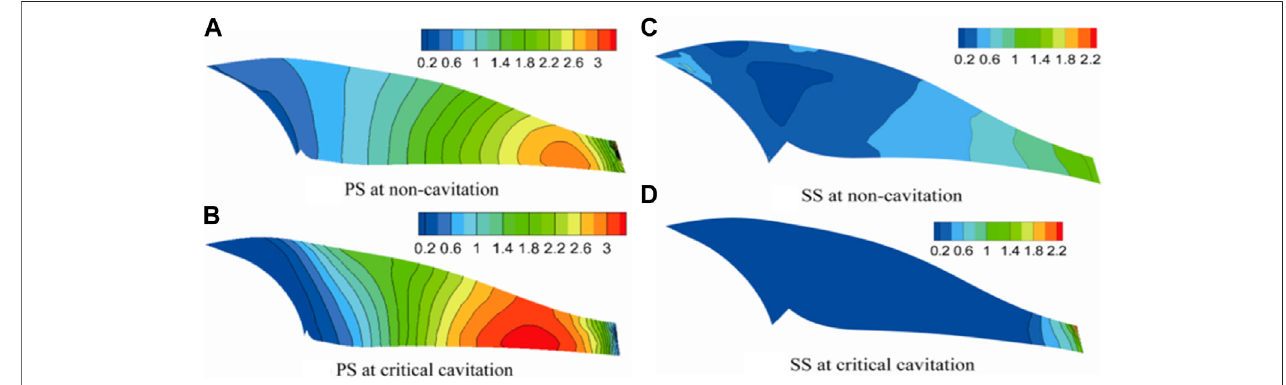
FIGURE 7 | P rms on PS and SS of the blade (Yeqiang Li, 2017). (A) PS at non-cavitation. (B) PS at critical cavitation. (C) SS at non-cavitation. (D) SS at critical cavitation.